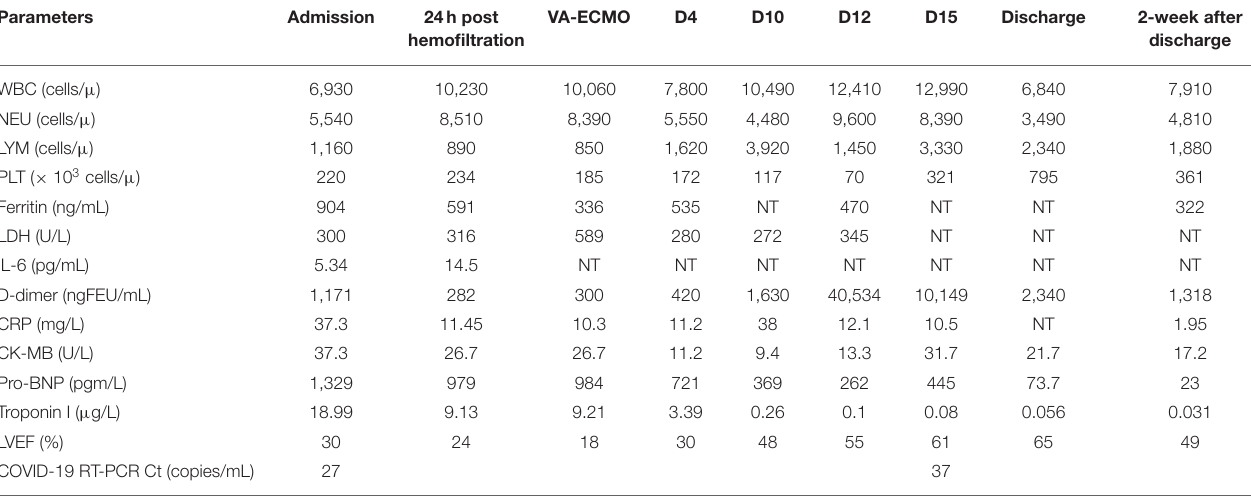
TABLE 1 | Laboratory